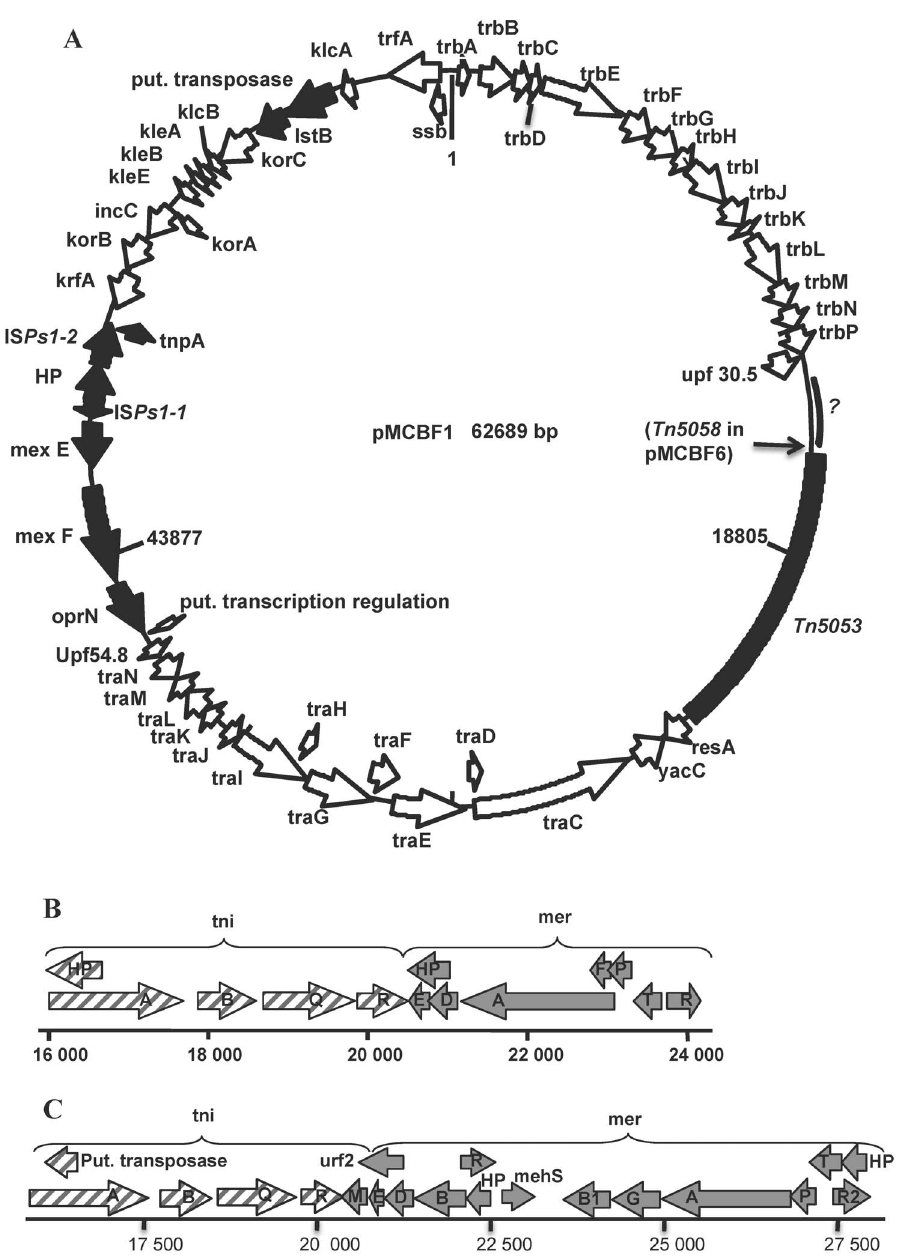
Figure. 1. Genetic map of the IncP-1 z plasmids pMCBF1 and pMCBF6. The backbones of the two plasmids are identical and differ only with regard to inserted transposons. Panel (A) shows pMCBF1 with Tn 5053 . Coding regions are shown by arrows, indicating the direction of transcription. Unfilled arrows denote plasmid backbone genes, black arrows denote accessory genes. An arrow points to the insertion site of Tn 5058 in the pMCBF6 backbone. The section of the pMCBF1/pMCBF6 backbone that has a low similarity to other sequences in the databases is marked with a question mark. Panels B and C shows transposon Tn 5053 on pMCBF1 and Tn 5058 on pMCBF6, respectively. Striped arrows denote genes in the transposition module (tni) and gray arrows denote mercury resistance (mer) genes. HP means hypothetical